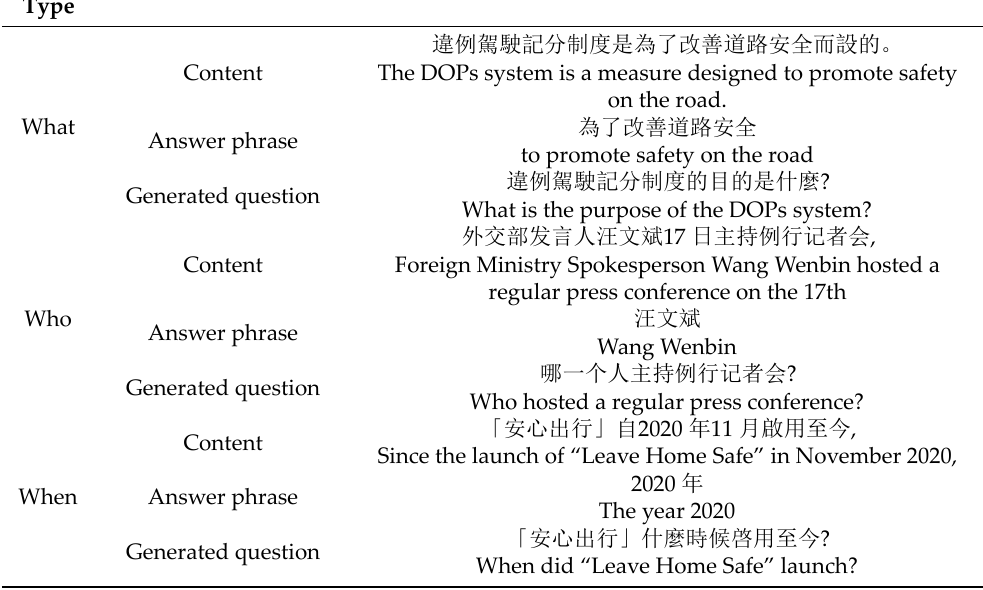
Table 3. Results of question‑type